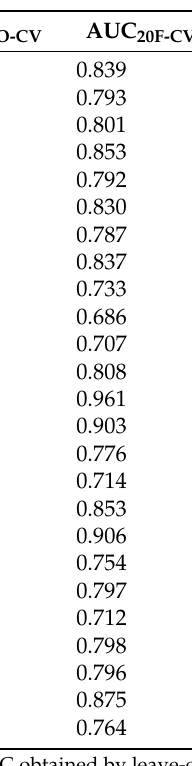
Table 1. The list of investigated proteins with associated diseases, data on training sets, and parameters of SSPR